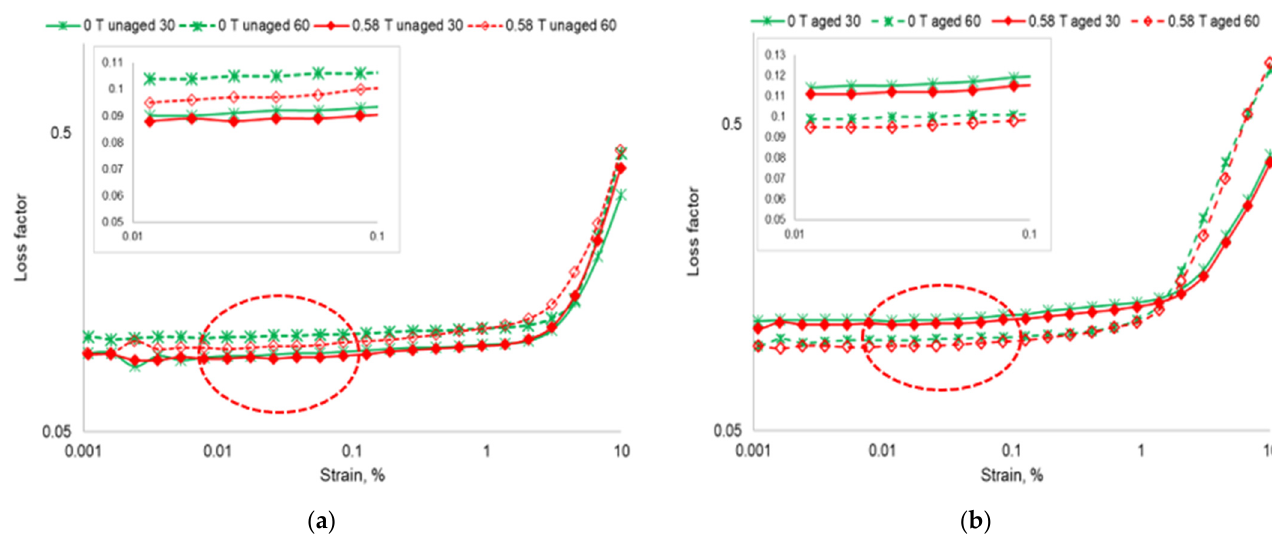
Figure 4. Comparison of loss factor of ( a ) unaged SR-MRE samples with 30 and 60 wt% of CIPs and ( b ) aged SR-MRE samples with 30 and 60 wt% of CIPs.